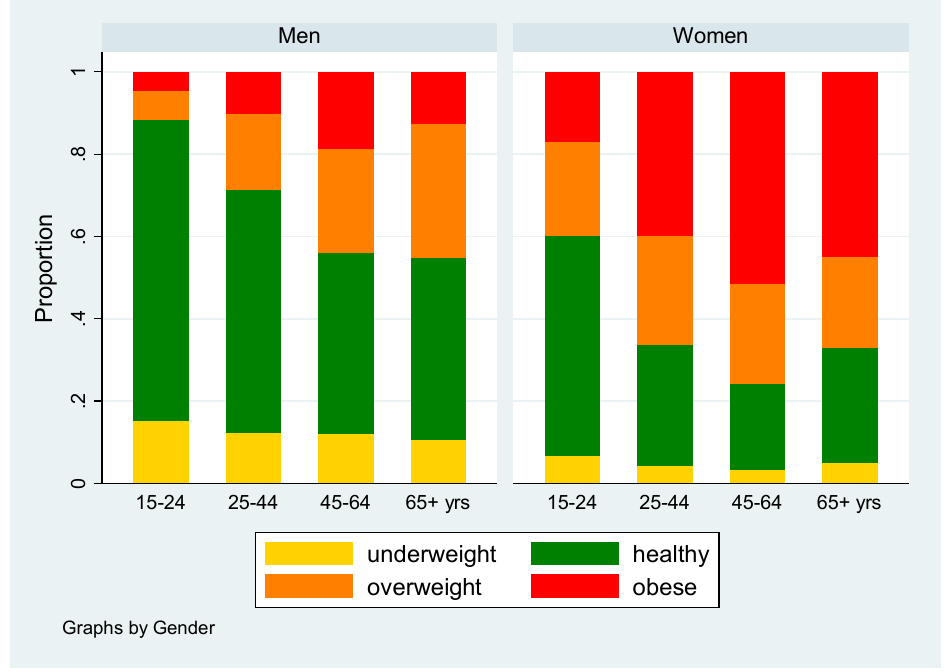
Figure 2. Distribution of body mass index (in percentiles and kilograms per square meters) categories among 2254 men and 4170 women from the SANHANES study in South Africa in 2012; by gender and age.